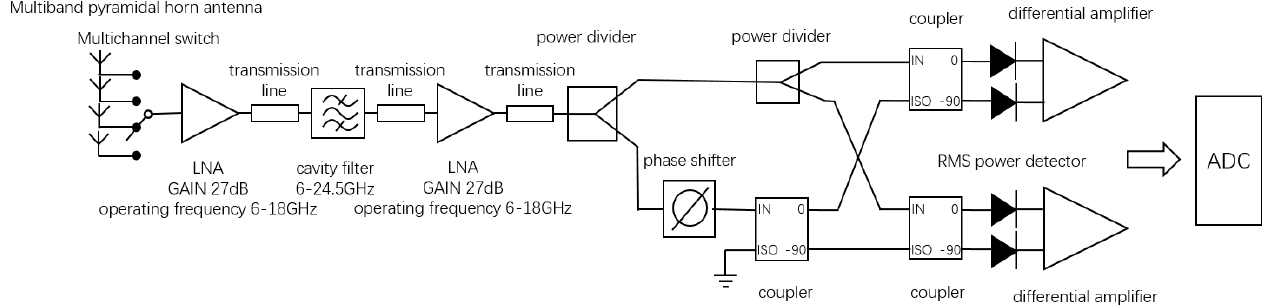
Figure 9. Block diagram of full-power microwave radiometer characteristics.